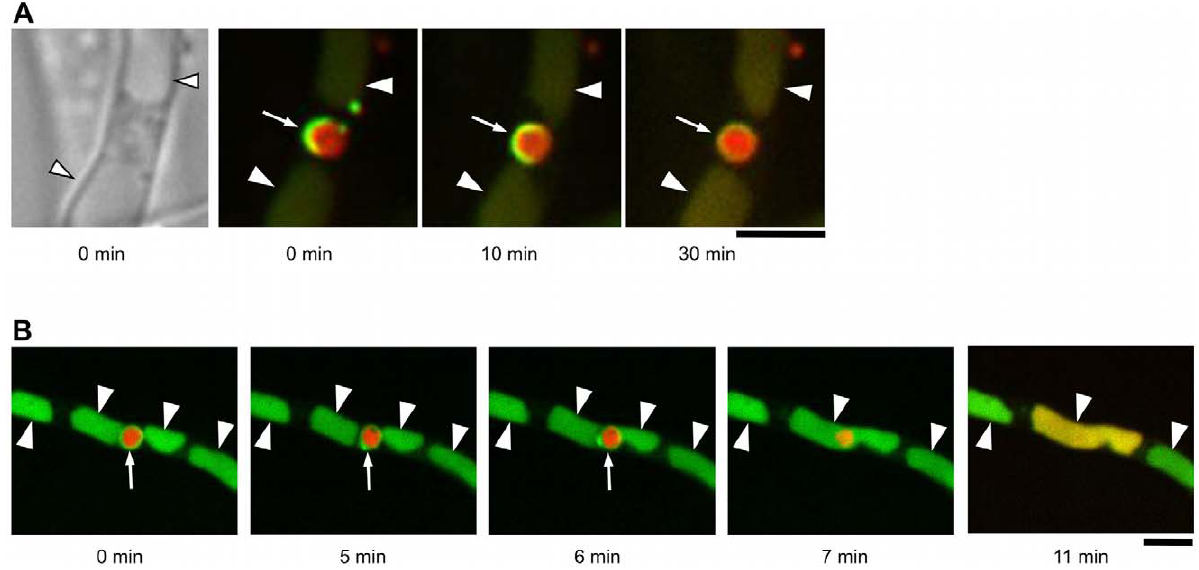
Figure 2. Macroautophagy-mediated uptake of nuclei by vacuoles. A series of superimposed images of EGFP-AoAtg8 and H2B-mDsRed is shown. (A) A crescent of an autophagosomal precursor (green, arrow) matured into a ring-like autophagosome to encircle an apparently intact nucleus (red). Arrowheads point to vacuoles. (B) A ring-like autophagosome (green, arrow) surrounding an apparently intact nucleus (red) disappeared (7 min), followed by dispersal of H2B-fused mDsRed throughout a vacuole. Arrowheads point to vacuoles. Bars represent 5 m m.